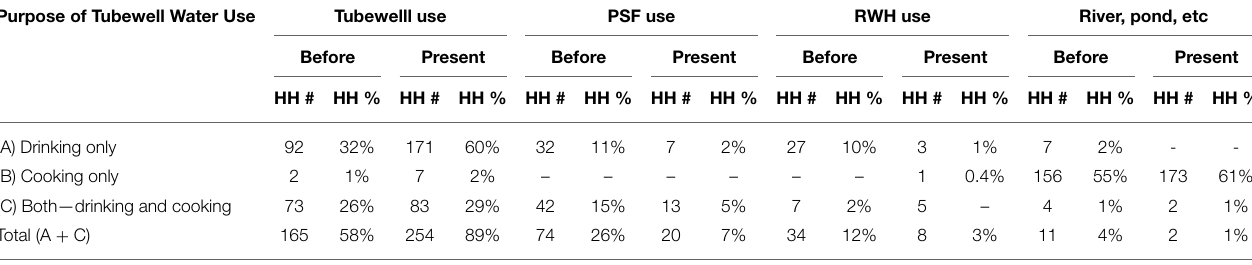
TABLE 8 | Source preference scenario of the surveyed households. Purpose of Tubewell Water Use Tubewelll use PSF use Before Present Before Present Before Present Before Present